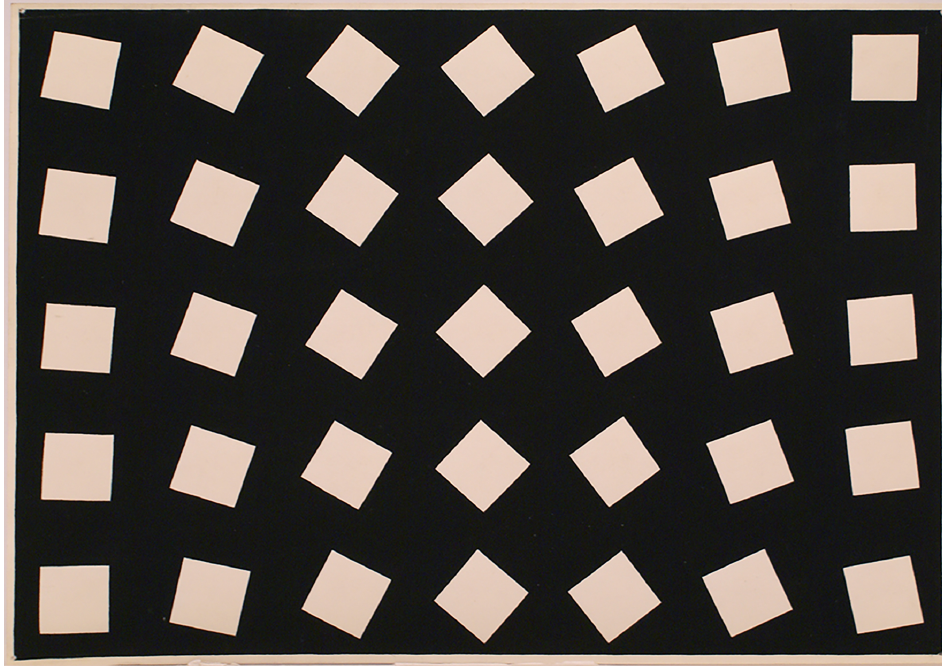
Figure 3: Jeffrey Steele, Square in Cinematic Rotation through 90 Degrees , 1960. Gouache on paper 26cm x 36cm, Collection British Museum,